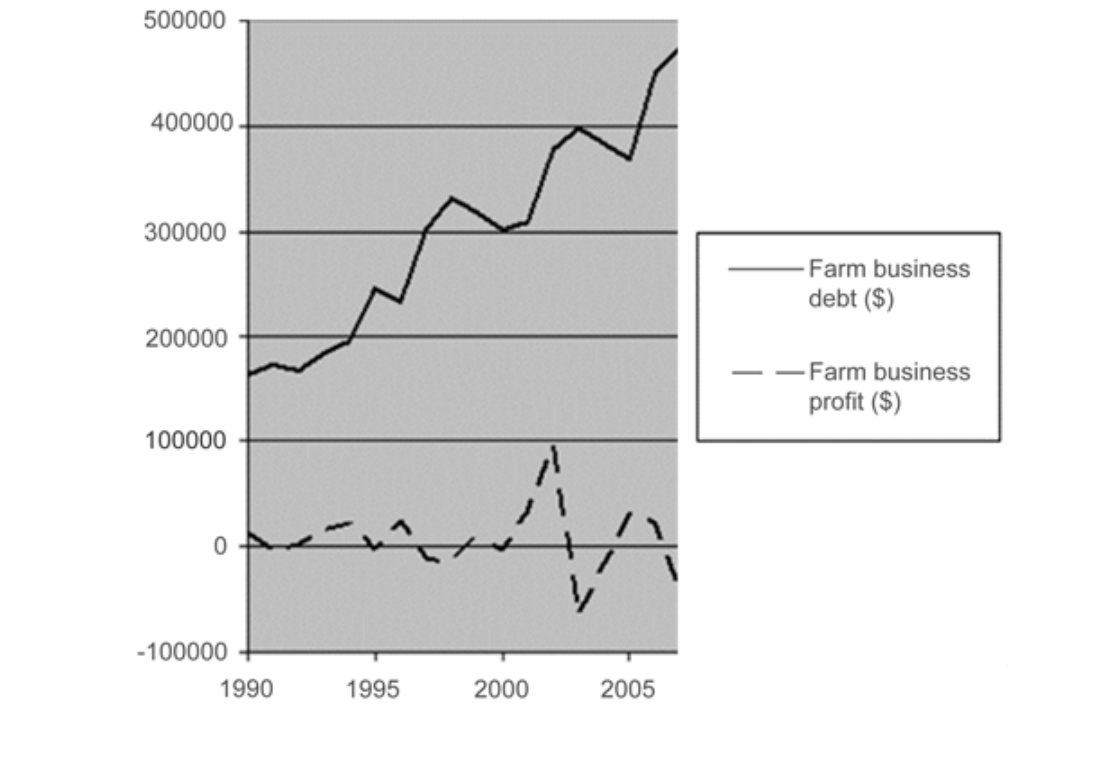
Fig. 4. Trends in profit and debt on Victorian dairy farms. Source: Australian Bureau of Agricultural and Resource